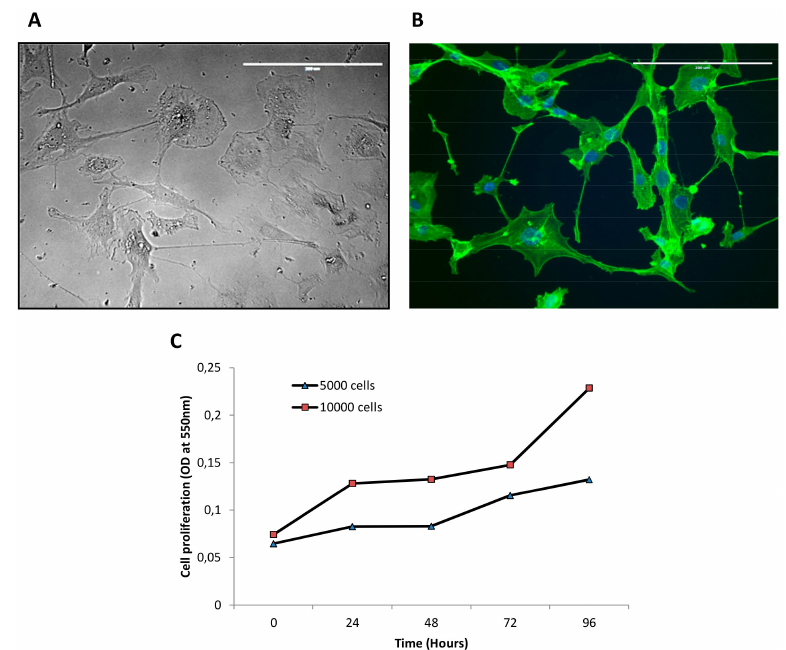
Figure 2. Morphologic and proliferation characterization of IM-MFS-1 cell line. A 40 × image of IM-FMS-1 cell line at passage 50. Scale bar 200 µ m ( A ). Immunofluorescence phalloidin staining showing the cell line morphology on a 2D monolayer support. Nuclei were counterstained with